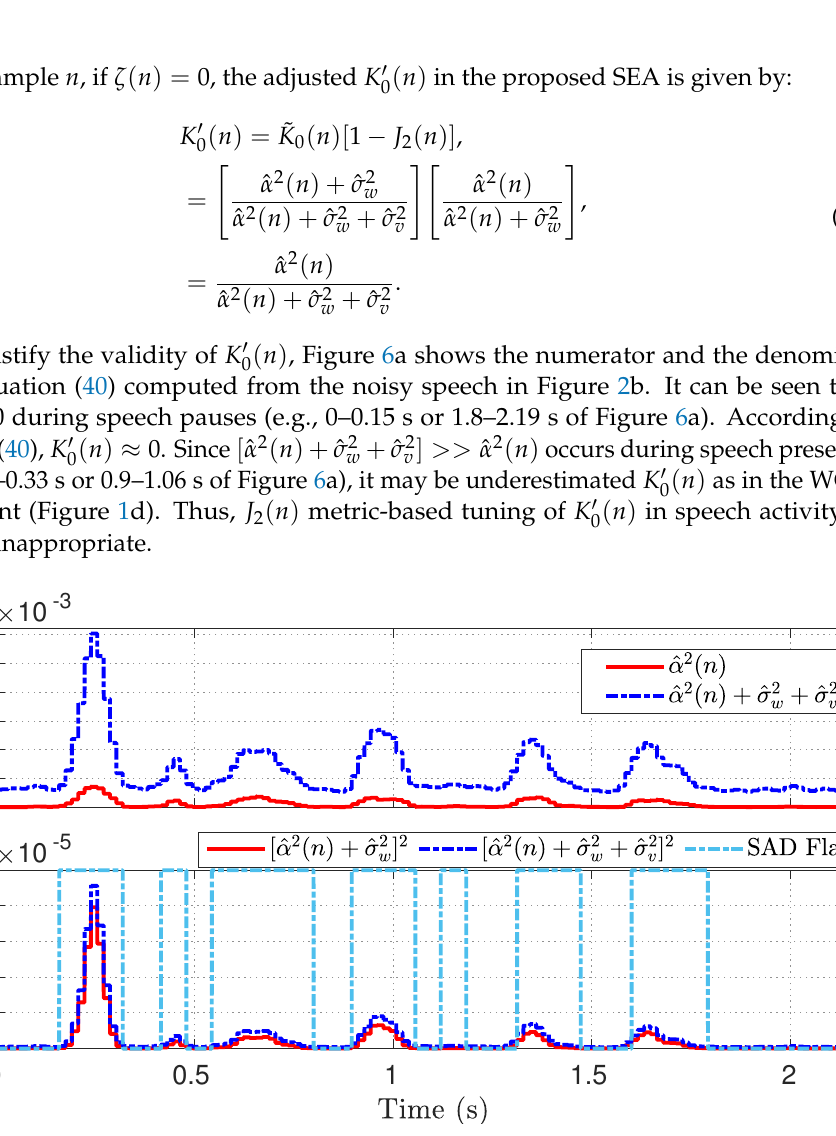
( n ) responses in terms of: ( a ) ˆ α 2 ( n ) and ˆ α 2 ( n ) + ˆ σ 2 Figure 6. K (cid:48) 0 [ ˆ α 2 ( n ) + ˆ σ 2 + ˆ σ 2 ] 2 , where the same experimental setup of Figure 2b is w v